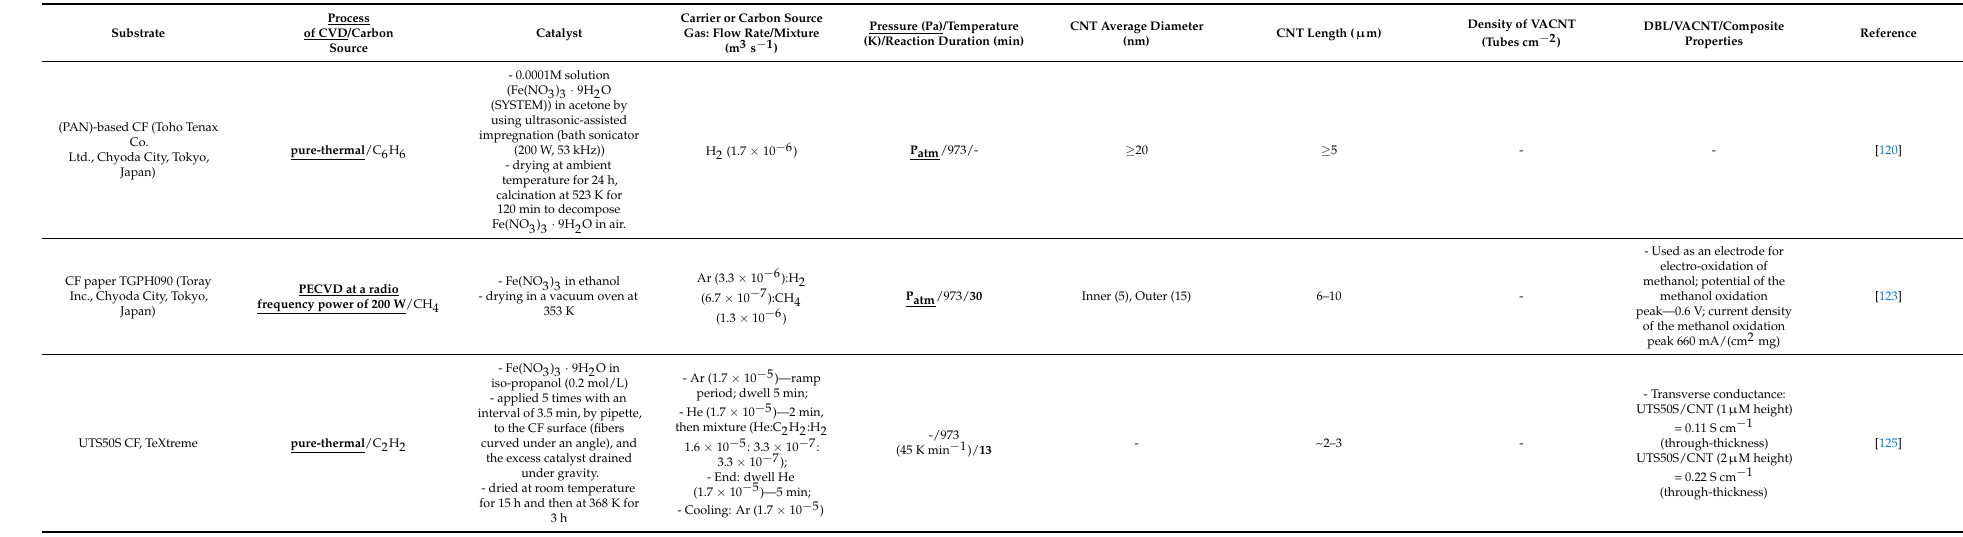
Table 8. Details of used carbonaceous fibrous substrates for direct growth of